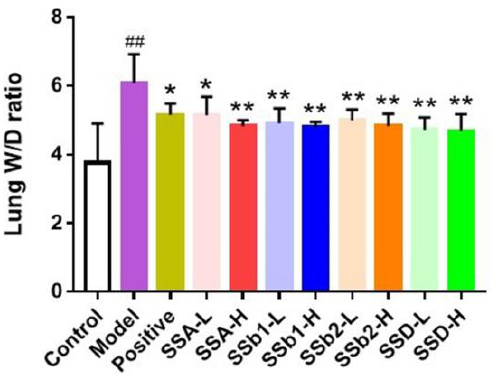
Figure 4. Effects of SSA, SSb1, SSb2, and SSD on lung W/D ratio in LPS-induced ALI mice ( n = 8, means ± SDs). Analyzed using a one-way ANOVA. ## p < 0.01 vs. control group; * p < 0.05, ** p < 0.01 vs. LPS-induced model group.